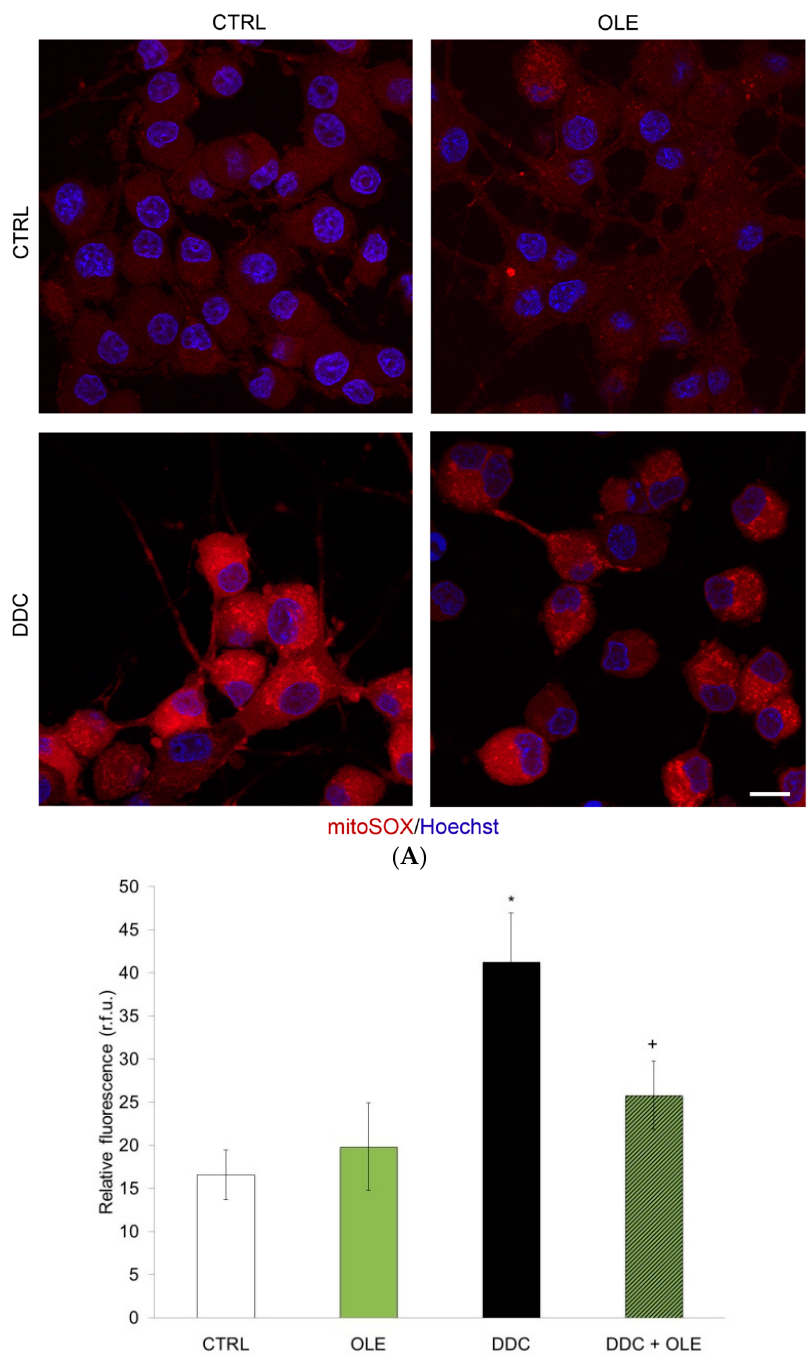
Figure 3. OLE mitigates mitochondrial superoxide anion production. ( A ) Mitochondrial superoxide anion, as revealed by specific mitochondrial MitoSOX™ Red fluorescent signal, is observed in cells exposed for 3 h to 80 µM N , N -diethyldithiocarbamate (DDC), a superoxide dismutase inhibitor used to evoke superoxide accumulation. When pre-treated for 3 h with 10 − 12 M OLE, neuronal PC12 cells exhibit reduced levels of red fluorescence. Untreated control and OLE-treated cells show similarly low fluorescence levels. Nuclei were counterstained with Hoescht 33342. Scale bar = 10 µm; ( B ) Histogram represents semi-quantitative measures of MitoSOX™ Red fluorescence. OLE significantly dampens mitochondrial reactive oxygen species (ROS) generation induced by DDC. Data are expressed as relative fluorescence units (R.F.U.) and are means ± SEM, n = 3. * p ˂ 0.05 compared to CTRL and + p ˂ 0.05 compared to DDC.